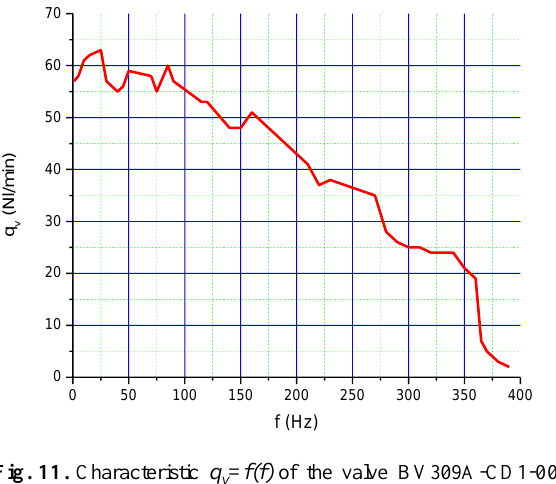
=f(f) of the valve BV309A-CD1-00- v